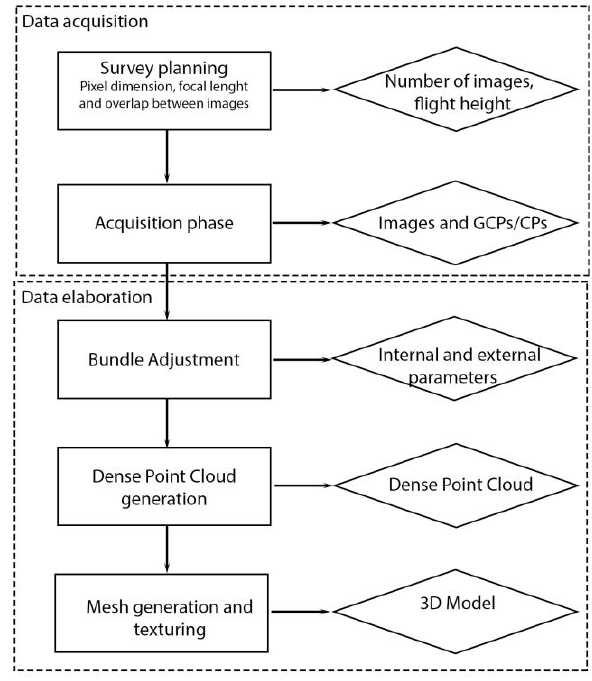
Figure 1. The methodology of UAV